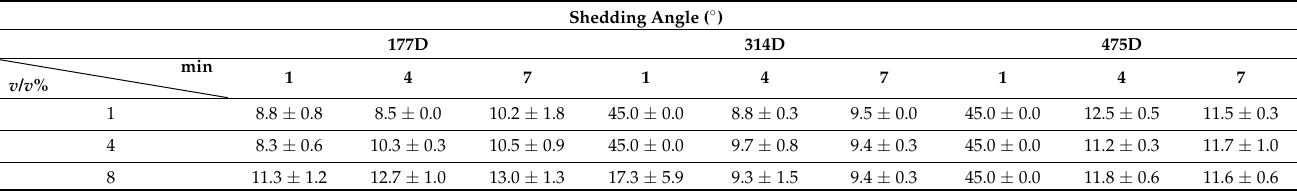
Table 4. Shedding angles of 177D, 314D, and 475D according to PDMS concentrations (1, 4, and 8 v / v %) and coating durations (1, 4, and 7